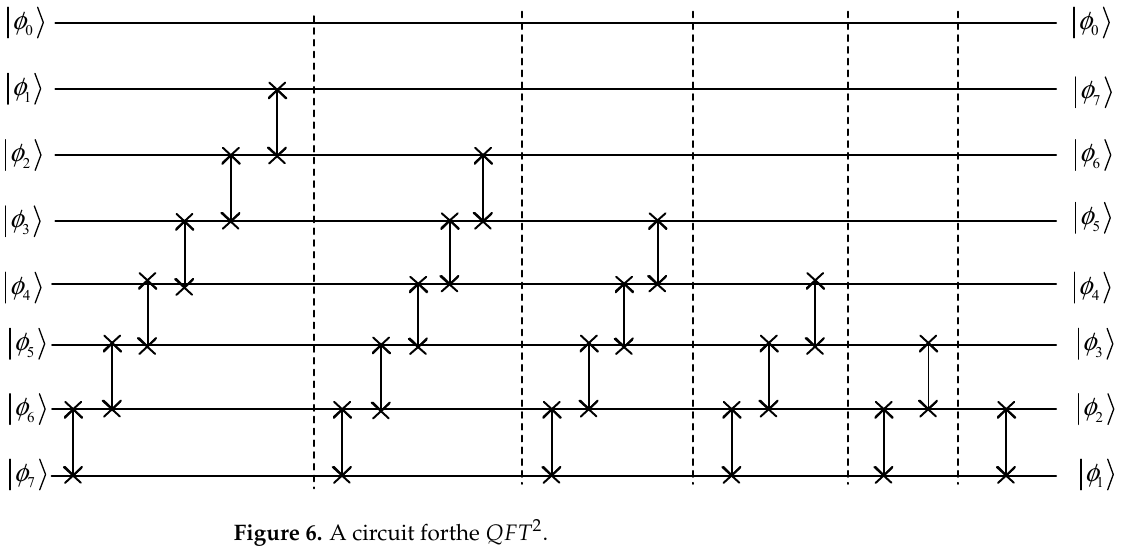
Figure 5. Swap gate. Thus, for 2 QFT , we provide quantum circuits of eight quantum states, as shown in Figure 6.